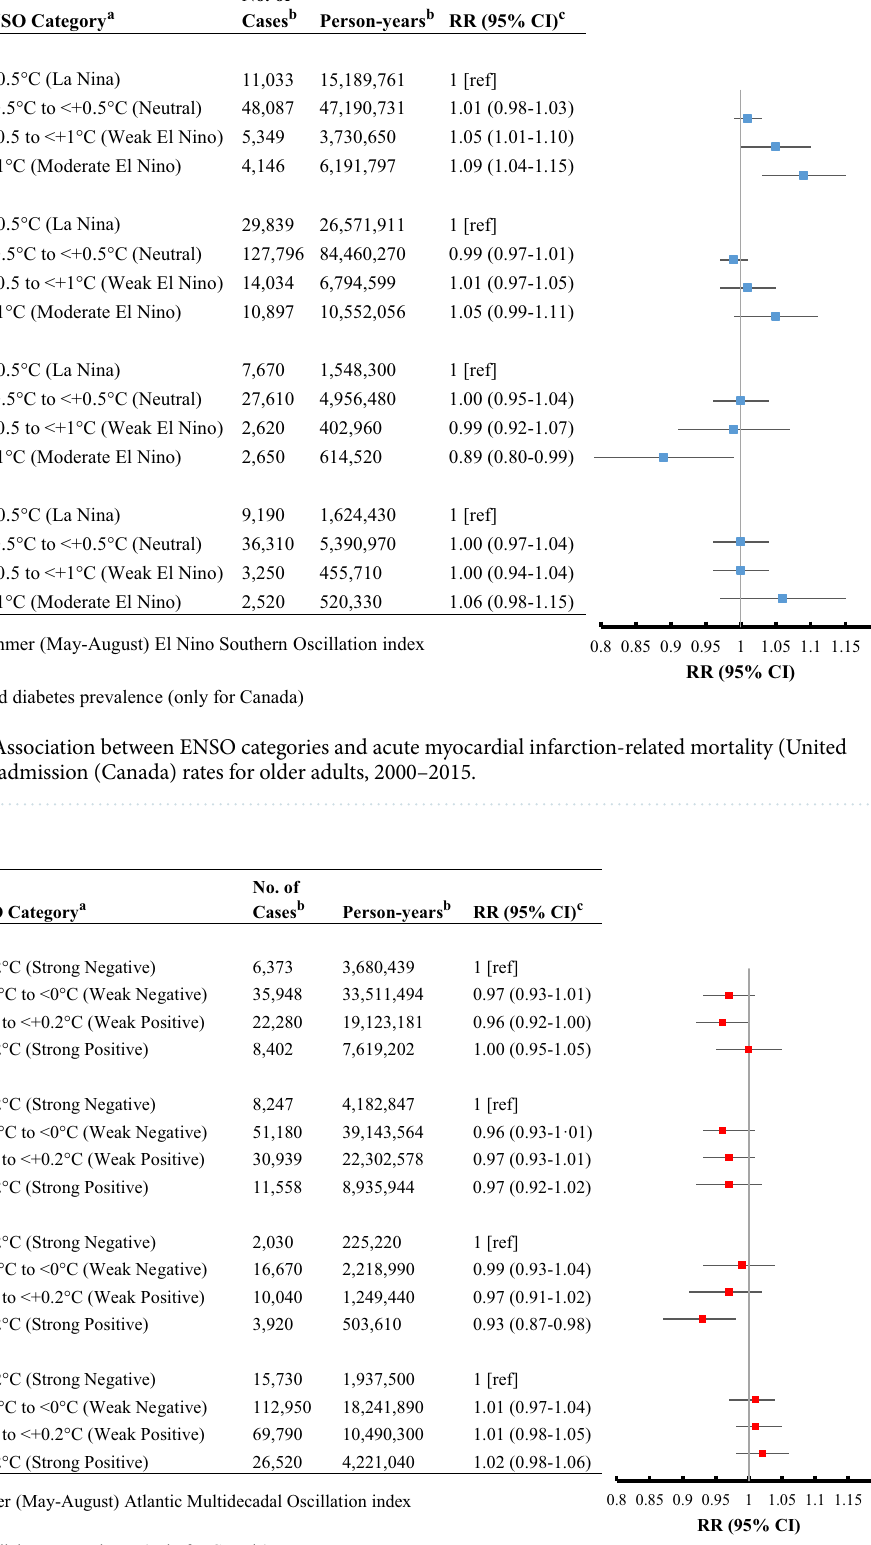
Figure 3. Association between AMO categories and acute myocardial infarction-related mortality (United States) and admission (Canada) rates for older adults,